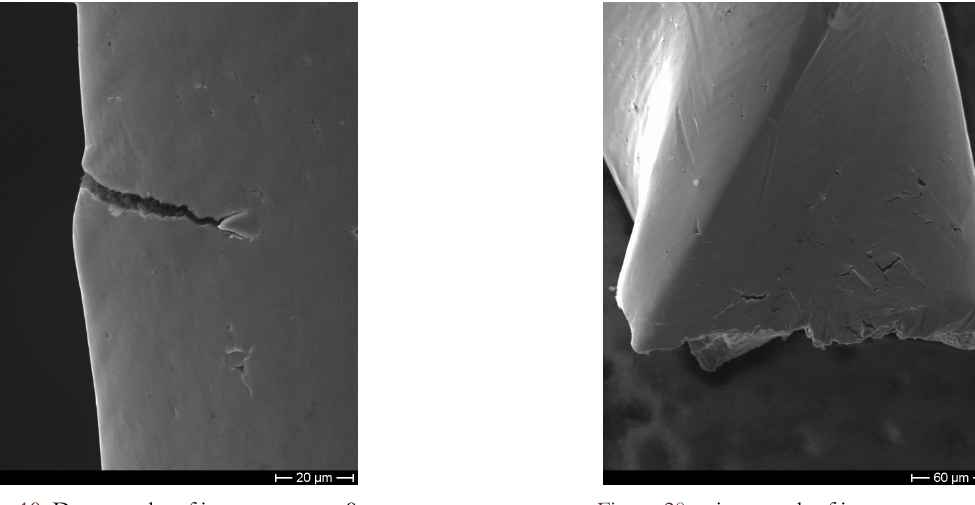
Figure 19: Deep cracks of instrument no. 9. Figure 20: micro crack of instrument no.